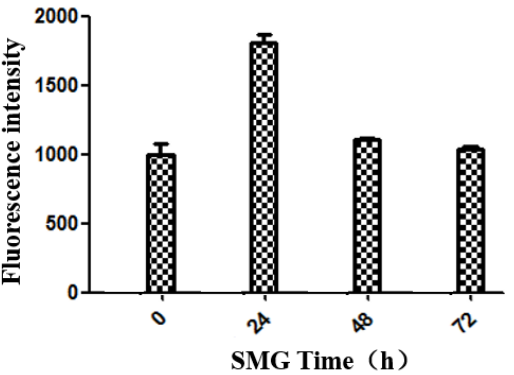
Figure 2. Permeability of HUVEC monolayer under SMG. HUVEC cells were plated on culture chamber and grown to confluence to form monolayer and set to 2D clinorotation. Then the permeability of HUVEC monolayer under SMG for 24, 48, and 72 h was assayed.